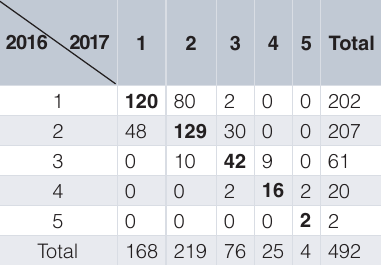
Table 4. Cross-tabulation of estimated clusters for universities in 2016 (rows) and 2017 (columns). The diagonal numbers in bold correspond to no change from 2016 to 2017. ‘5’ is the highest cluster with the best